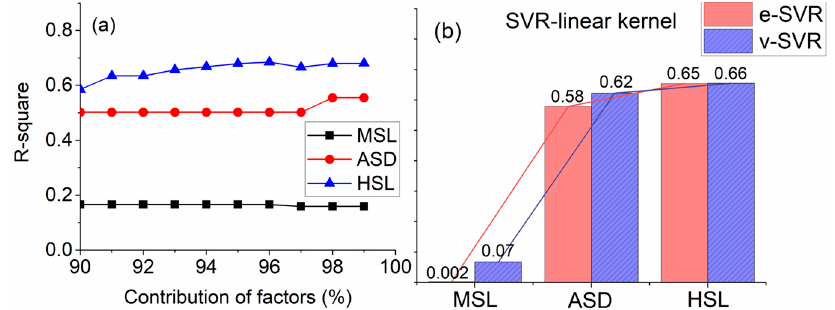
Figure 3. The estimation R 2 of LNC using reflectance spectra from MSL, ASD, and HSL with two linear regression algorithms—( a ): partial-least square regression (PLSR) with varying contribution of factors and ( b ): support vector regression (SVR) with a linear kernel (with different types of SVR) . Other parameters were settled through 5-fold validation.